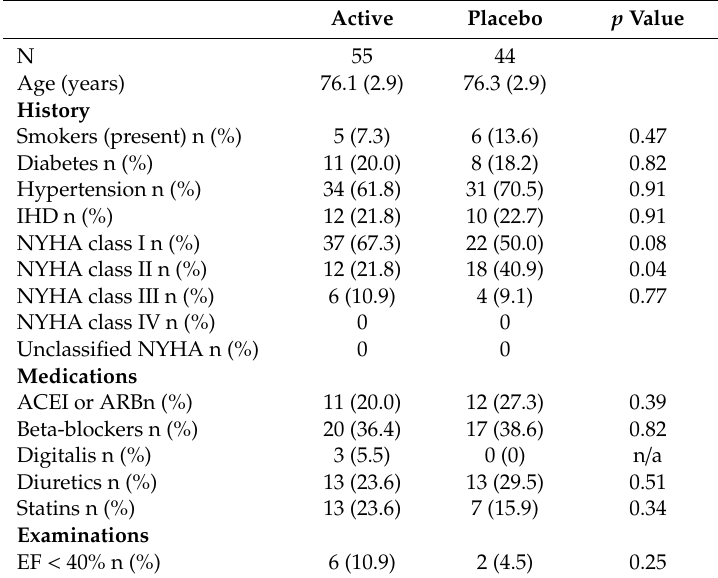
Table 1. Baseline characteristics of the male study population receiving an intervention of dietary supplementation of selenium and coenzyme Q 10 combined over four years. Active